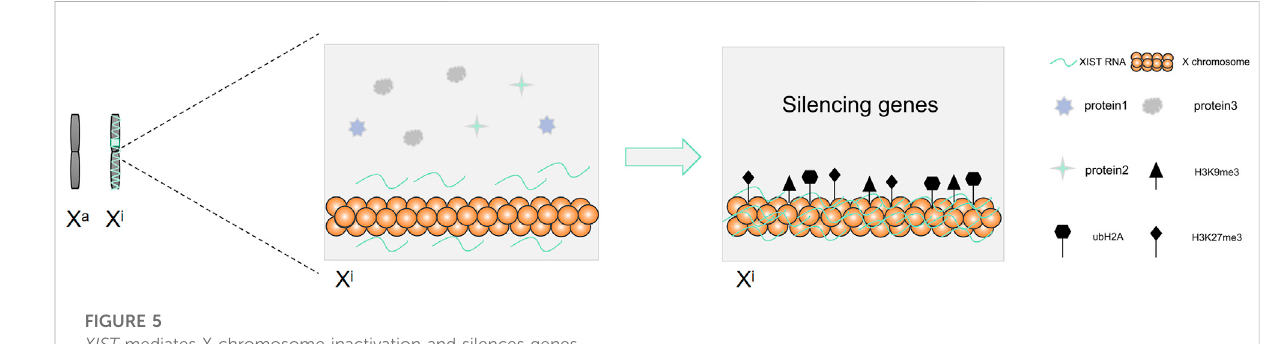
FIGURE 5 XIST mediates X chromosome inactivation and silences